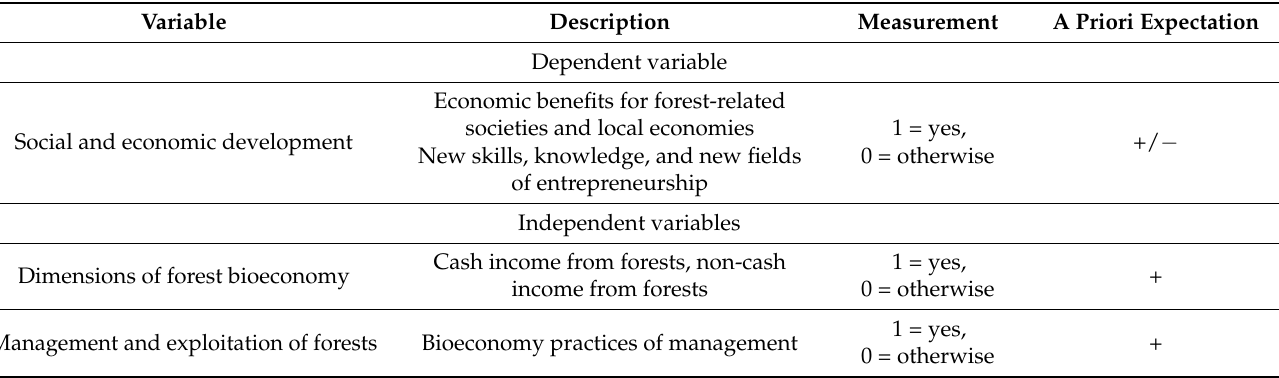
Table 2. Description and measurement of variables and their a priori expectations.